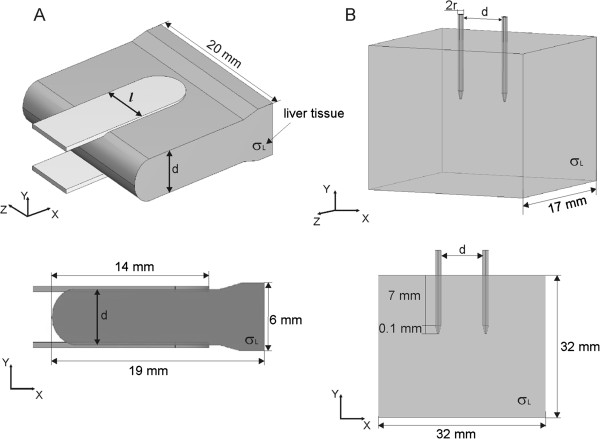
Geometry of numerical models of liver tissue. A. treated with plate electrodes and B. treated with needle electrodes. The parameter σL stands for the conductivity σ [S/m] of liver tissue.